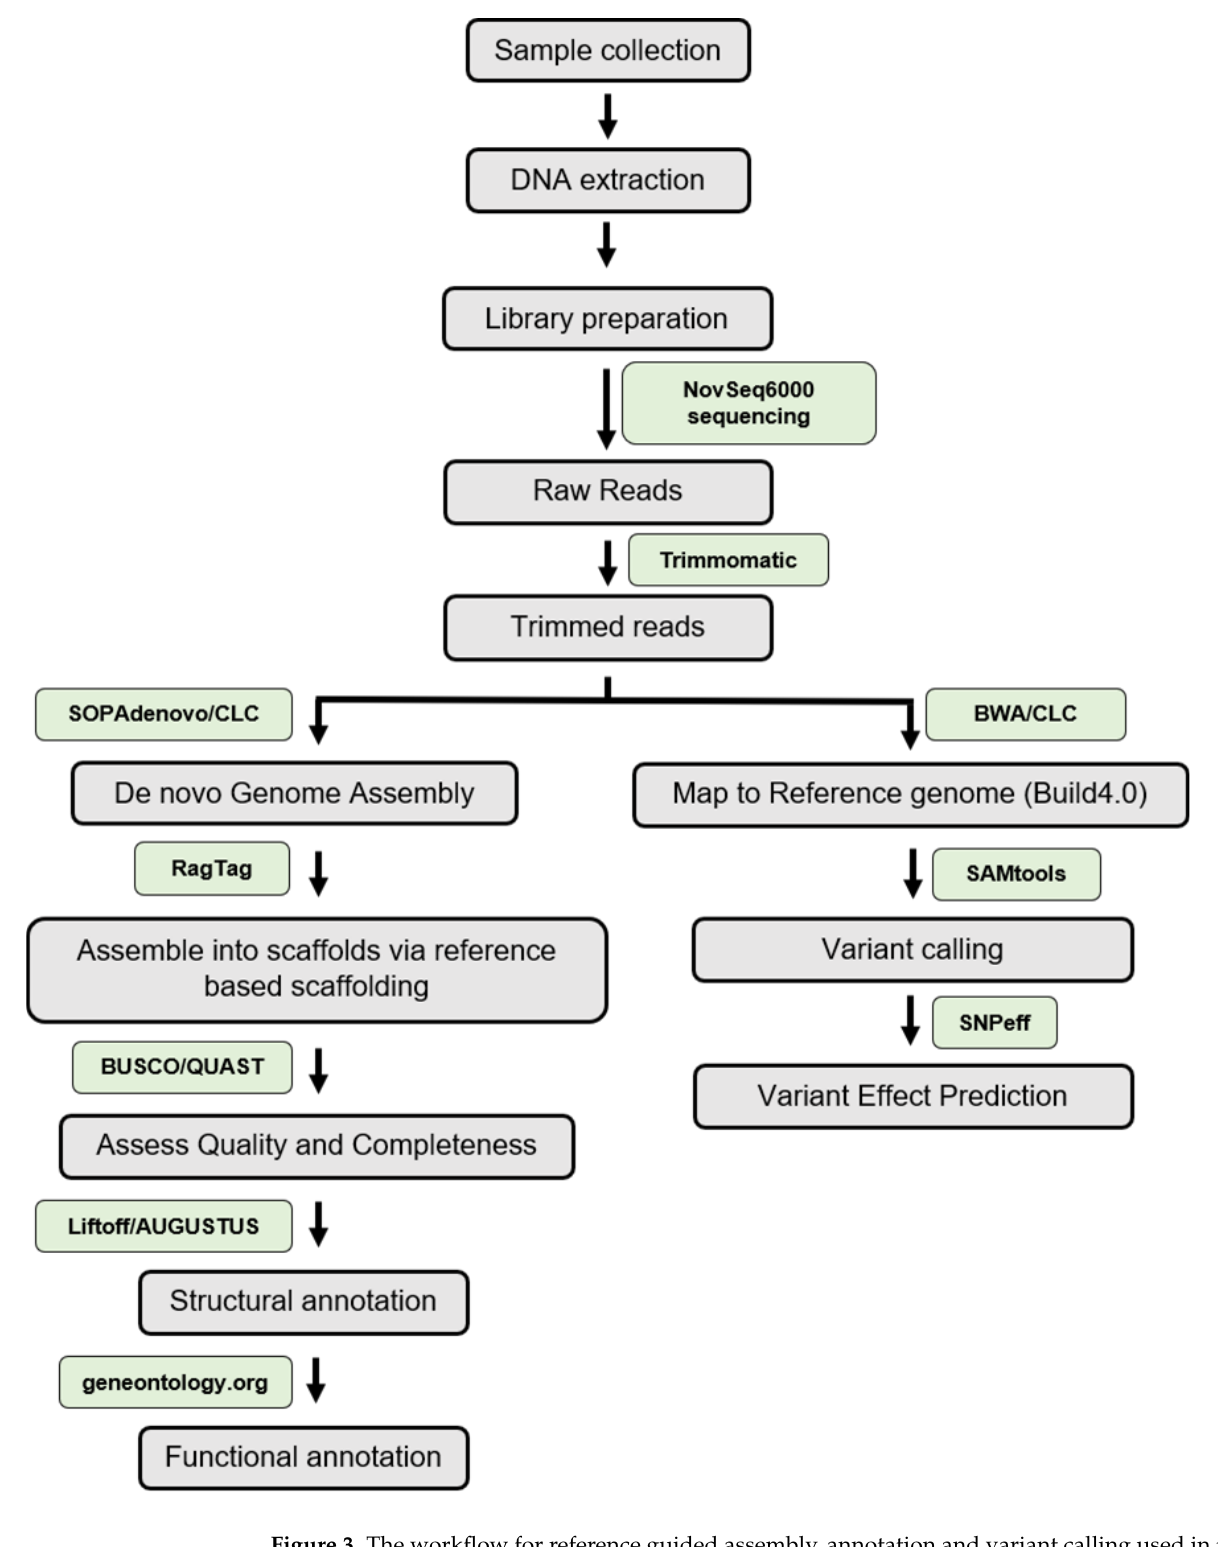
Figure 3. The workflow for reference guided assembly, annotation and variant calling used in this study. The major tools used have been highlighted in green boxes.